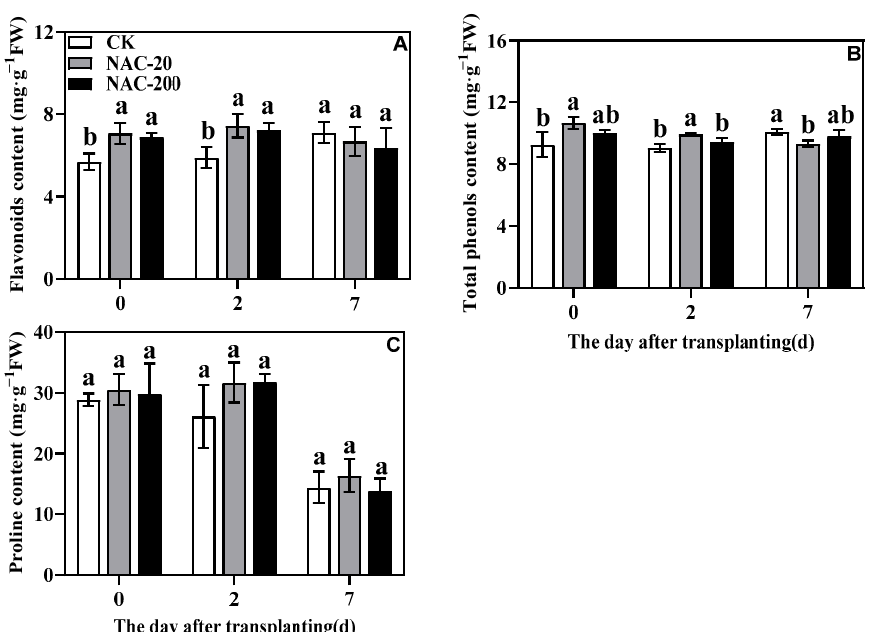
Figure 8. Effects of different concentrations of NAC on flavonoids ( A ), total phenols ( B ), and proline ( C ) content. CK, 0 µ m; NAC-20, 20 µ m; NAC-200, 200 µ m. Data are means ± SD ( n = 3). The different letters following average values indicate significant difference (Duncan, p < 0.05).